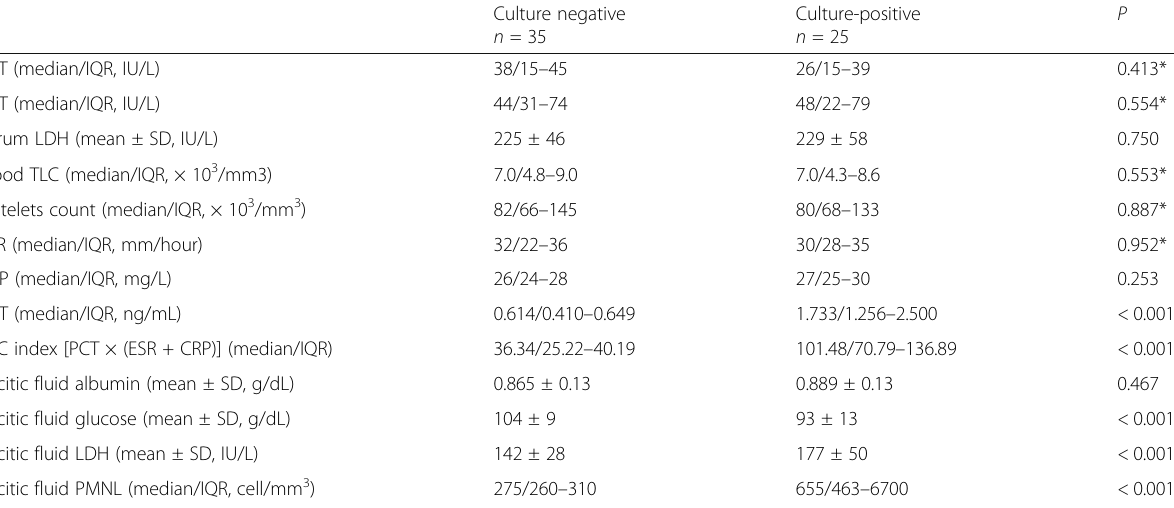
Table 2 Comparison between culture-positive and culture-negative SBP patients, regarding serum and AF biomarkers